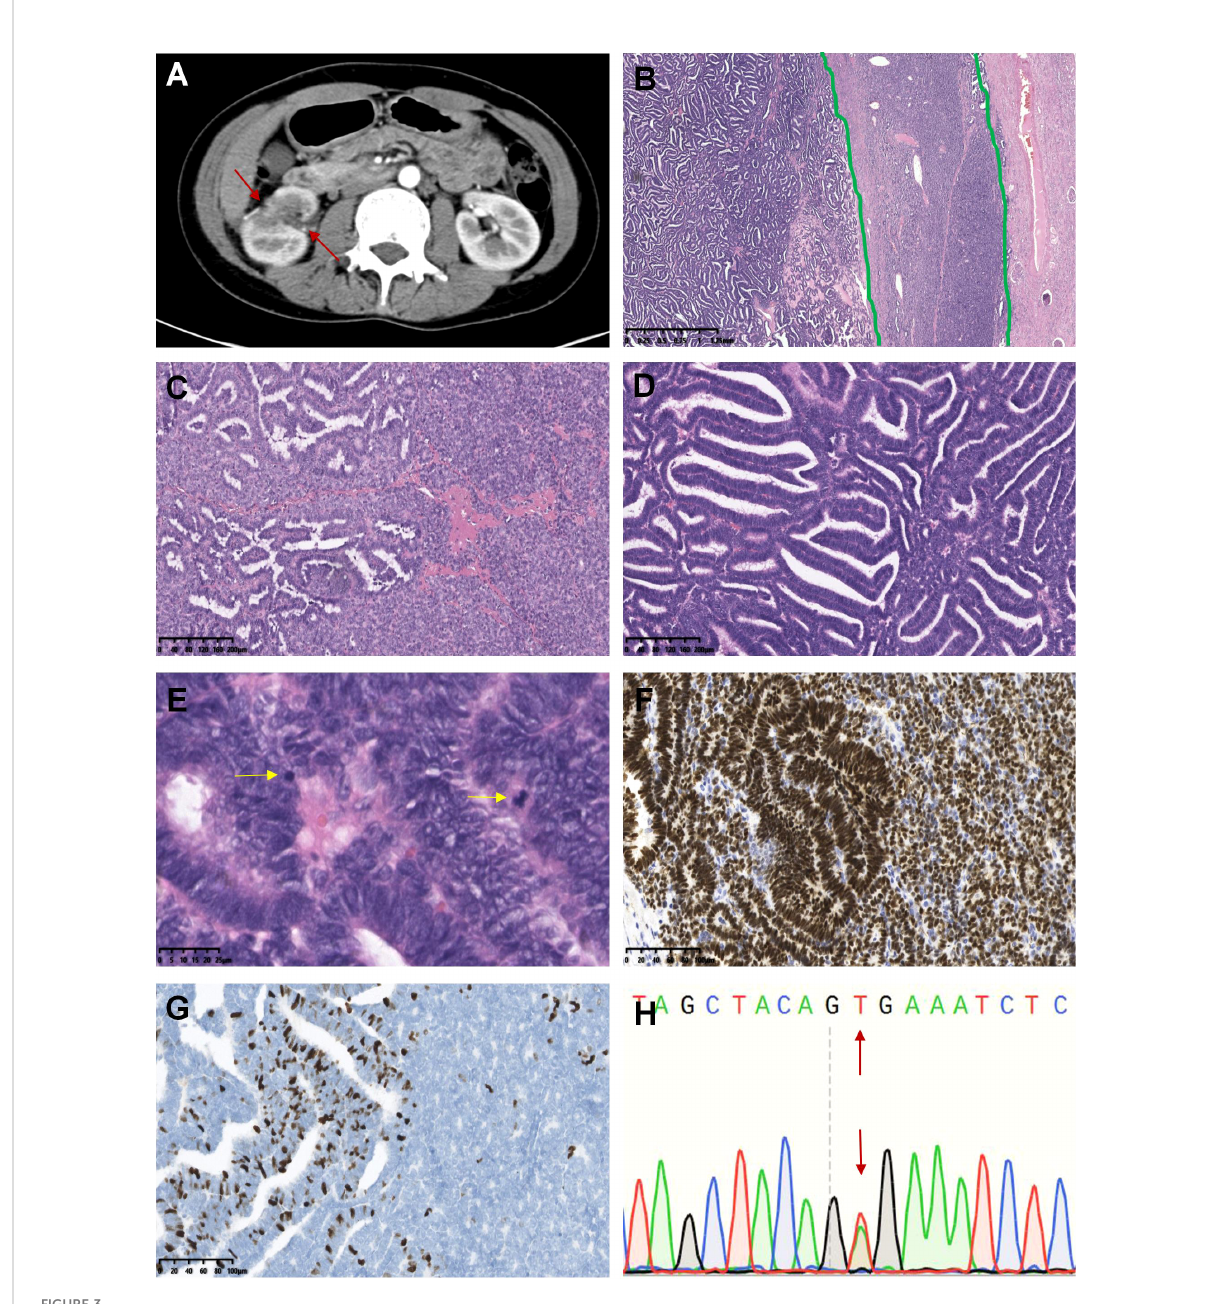
FIGURE 3 Tumors with overlapping morphologic features of MA and epithelial-predominant WT (case 31-39). The representative morphological images were displayed as follows: A large mass was observed in the middle and upper parts of the right kidney in computer tomography scan (axial, case 38). The mass was irregularly bound, compressing the surrounding renal tissue, and the tumor parenchyma was markedly heterogeneously enhanced (A) . The green lines divided the tissue into three areas: the tumor demonstrated discrete areas that were predominantly composed of epithelial WT (left) but had a narrow strip area (middle) associated with cuboidal mitotically inactive epithelium consistent with MA (B) . Excessive abruptness and unclear boundaries between the two structures of the tumor (C) . The majority of tumors demonstrated primitive columnar- shaped neoplastic cells with papillotubular or rosette-like architectures, typical of epithelial-predominant WT (D) . The yellow arrow indicates pathological mitotic fi gures (E) . WT1 was positively expressed in the tumor (F) , and Ki-67 expression in the WT-like area was signi fi cantly higher than that in the MA-like area (G) . The tumor showed the BRAF V600E mutation (H)